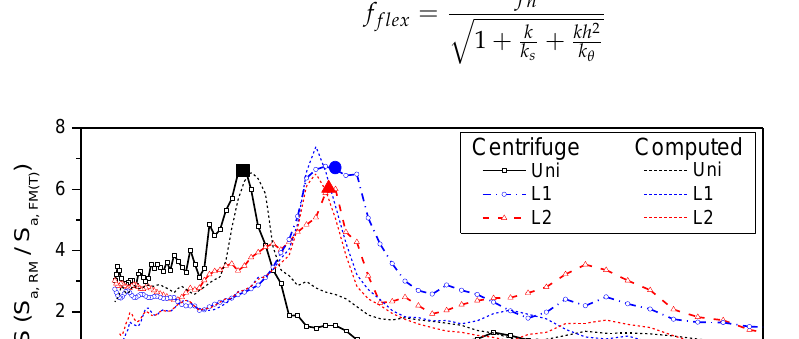
Figure 7. Comparison of period lengthening ratio (PLR) for the S1 structure on L1 and L2 profiles to those on Uni profile. Recently, rocking behavior and its effects on SFSI have been defined and recognized [34–38]. During a strong earthquake, the overturning moment (M) at the foundation level, which is generated by the inertial response of the above structure, is restricted by the ul- timate moment capacity of the foundation, and, therefore, the seismic response is limited. In this study, the overturning moment at the surface of the foundation and the rocking angle of the structure in the time domain were identified based on measured values from two vertical accelerations attached to the foundation and three pairs of strain gauges at- tached to the structure’s walls [23,24]. The rocking stiffness ( k θ ) can be estimated from the hysteretic backbone curve of the overturning moment and rocking angle. An example is illustrated in Figure 8a for the S1 structure at a PGA BM of 0.1 g and 0.3 g . The overturning moment was normalized to the ultimate moment capacity (M ult = W p ∙L(1-1/FS v )/2), which is defined based on structure weight (W p ), foundation length (L), and soil strength through the vertical safety factor (FS v ) [24,39,40]. The estimated overturning moment in- creased with an increase in rocking angle; however, it was limited by the M ult of the SFS system that reduced the structure response during high-intensity earthquakes [38]. The rocking stiffness ( k θ ) was calculated from these backbone curves and then normalized to the maximum rocking stiffness ( k θ,Max ), as shown in Figure 8b [24,39]. The k θ,Max can be